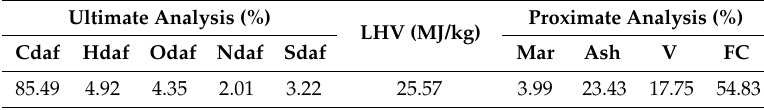
Table 1. Proximate and ultimate analysis data of the used coal.